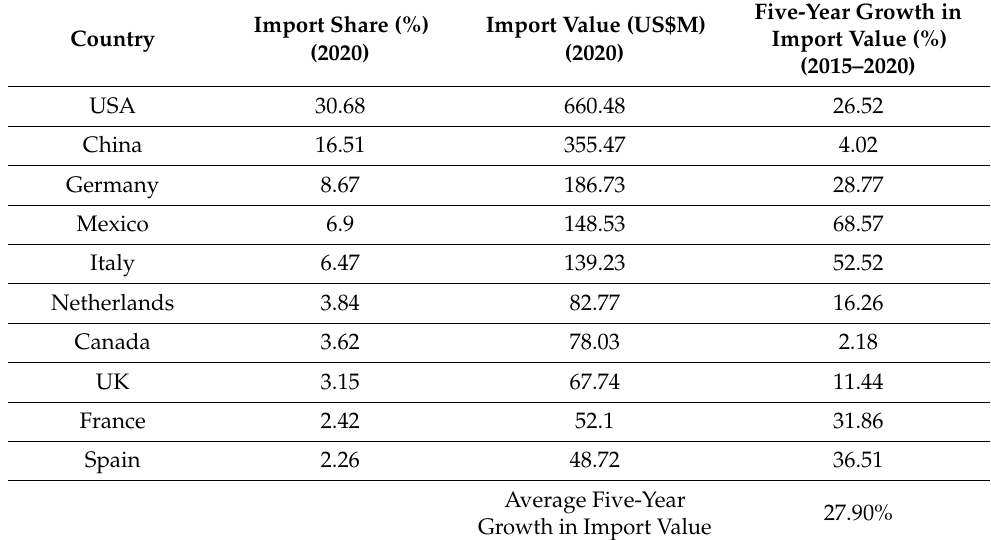
Table 1. Tigernut importation share and importation value in 2020; and five-year growth in import value among the top 10 importing countries (Source: Tridge—https://www.tridge.com/intelligences/ tiger-nut/import, accessed on 27 January